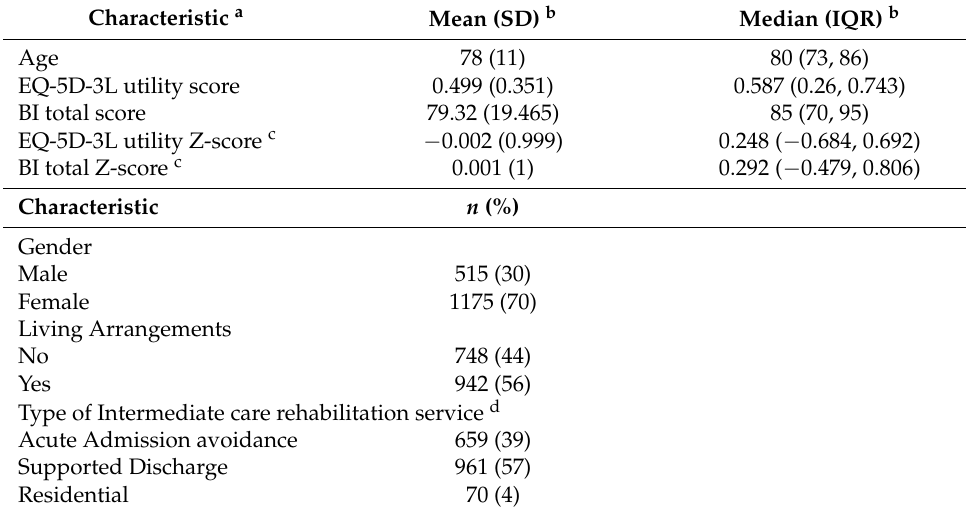
Table 2. Baseline characteristics of the study